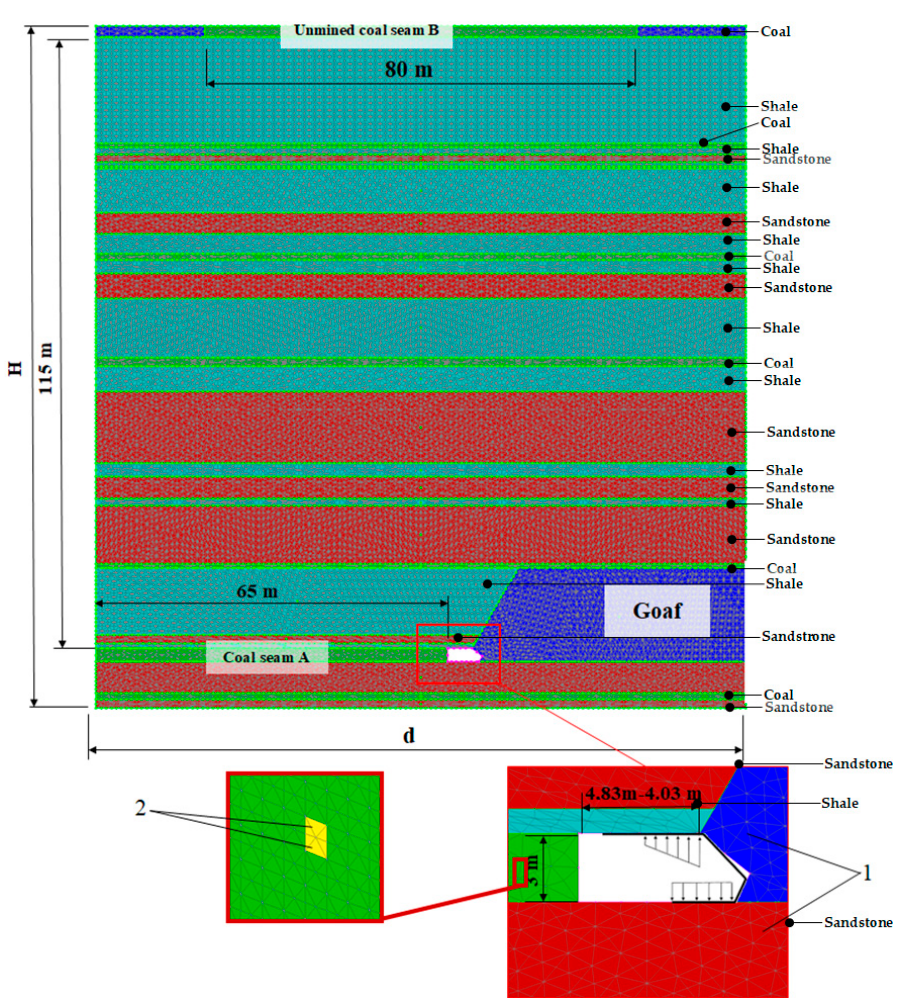
Figure 6. Numerical grid of the cross-section of the analyzed rock mass for variant III: 1—blocks, 2—deformed zones.